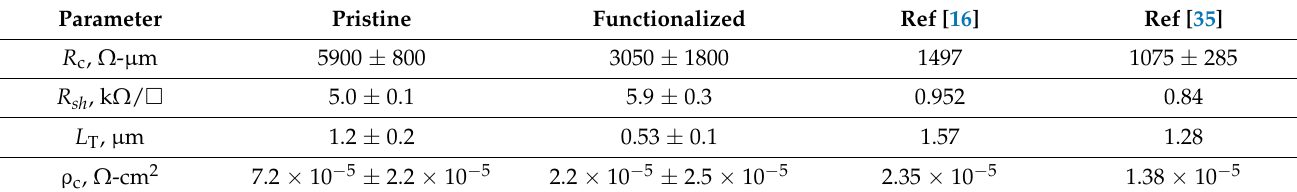
Table 2. Electrical characteristics of pristine and functionalized graphene films with evaporated Ti/Au contacts calculated using the TLM data in Figure 3 (contact width = 20 µ m, length = 5 µ m). Data from ref [16] refers to CVD graphene with Al/Cr/Au contacts, measurements from TLM structures. Data from ref [35] refers to annealed graphene, measurements from TLM